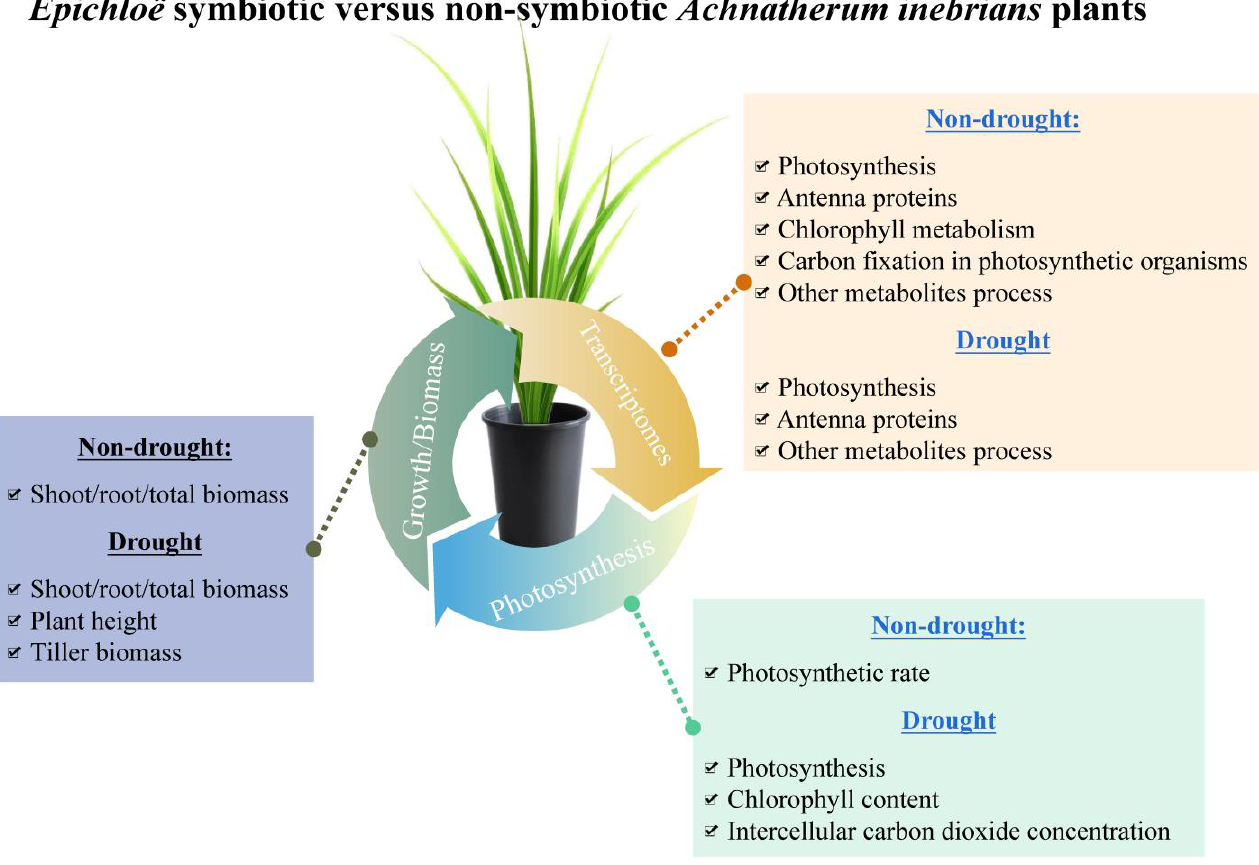
Figure 5. The overview diagram for understanding the advantages of Epichloë symbiotic Achnath- erum inebrians plants versus non-symbiotic plants combining the transcriptomes, photosynthesis, and